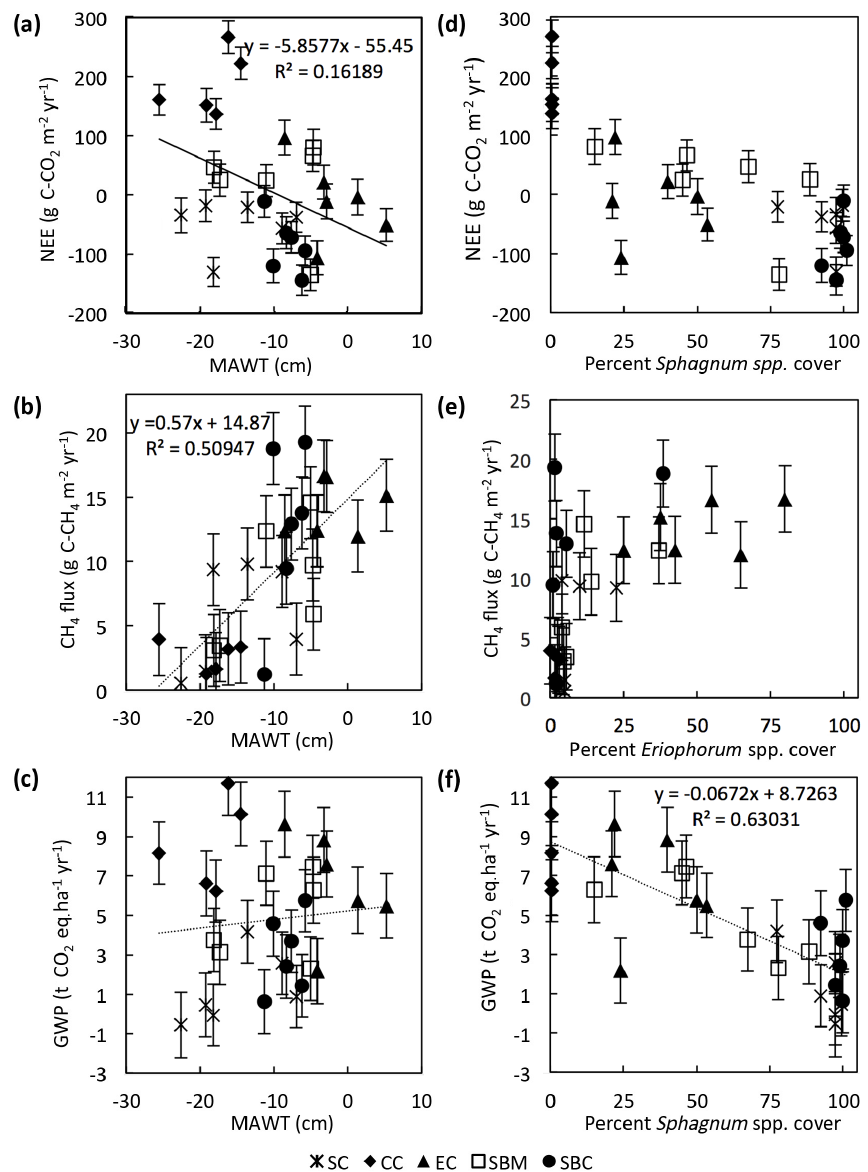
Figure 10. Trends in collar annual C balance, CH 4 flux, and GWP plotted against mean annual water table (MAWT) (a–c) and percentage of genus cover (d–f) . Data are displayed by ecotype with abbreviations in the legend as in Fig. 2.